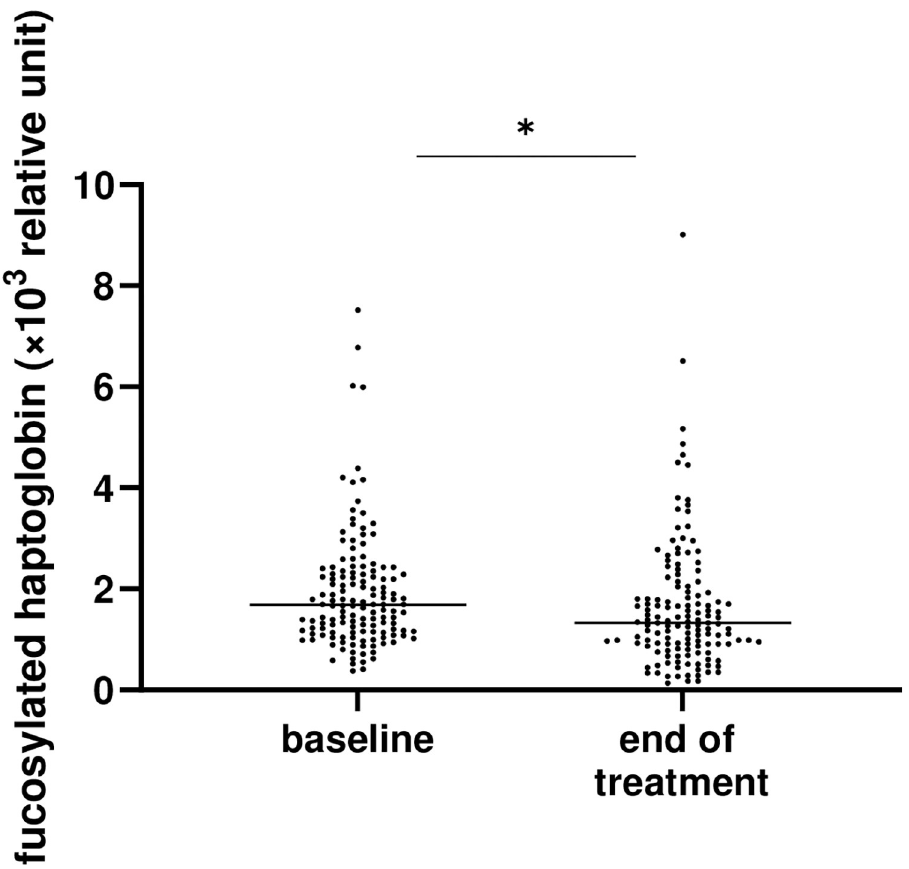
Fig 2. The serum levels of fucosylated haptoglobin at baseline and the end of treatment. relative unit at baseline (Fig 2). When divided the patients into two groups according to the median Fuc-Hp level, and patients with a higher Fuc-Hp level at baseline had higher aspartate transaminase (AST), higher alanine aminotransferase (ALT), higher γ -glutamyltransferase (GGT), higher type IV collagen 7S, and higher AFP at baseline (S2 Table). Patients who were female and had higher AST, higher ALT, higher total bilirubin, higher hyaluronic acid, higher type IV collagen 7S, and higher fibrosis-4 (FIB-4) index at the end of treatment (EOT) were more likely to have higher Fuc-Hp levels at EOT (S3 Table).